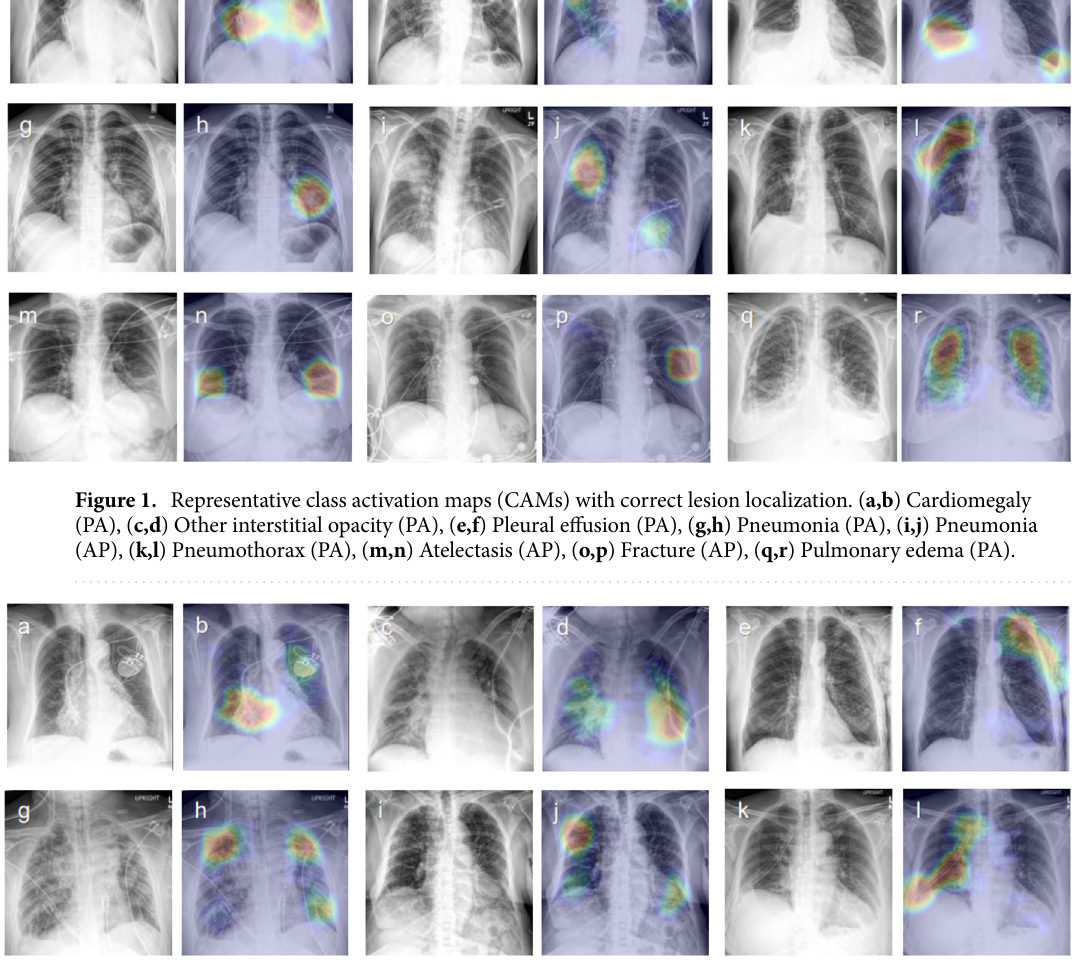
Figure 2. Representative class activation maps (CAMs) with incorrect lesion localization. ( a,b ) Cardiomegaly (PA), ( c,d ) Cardiomegaly (AP), ( e,f ) Pneumothorax (PA), ( g,h ) Other interstitial opacity (AP), ( i,j ) Other interstitial opacity (AP), ( k,l ) Pneumothorax (AP ) . ( b ) Attention map captures the tip and body of the implantable cardioverter defibrillator (ICD) rather than the enlarged heart, ( d ) Attention map captures pulmonary edema along with the enlarged outline of heart in cardiomegaly, ( f ) Attention map captures subcutaneous emphysema along with pneumothorax, ( h,j ) Attention map failed to capture the full area of diffuse interstitial opacities, ( i ) Attention map captures chest tube instead of